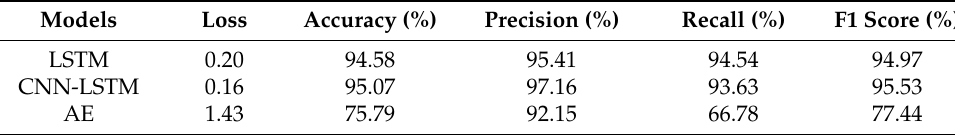
Table 8. Results of the deep learning algorithms in the CICAndMal2017